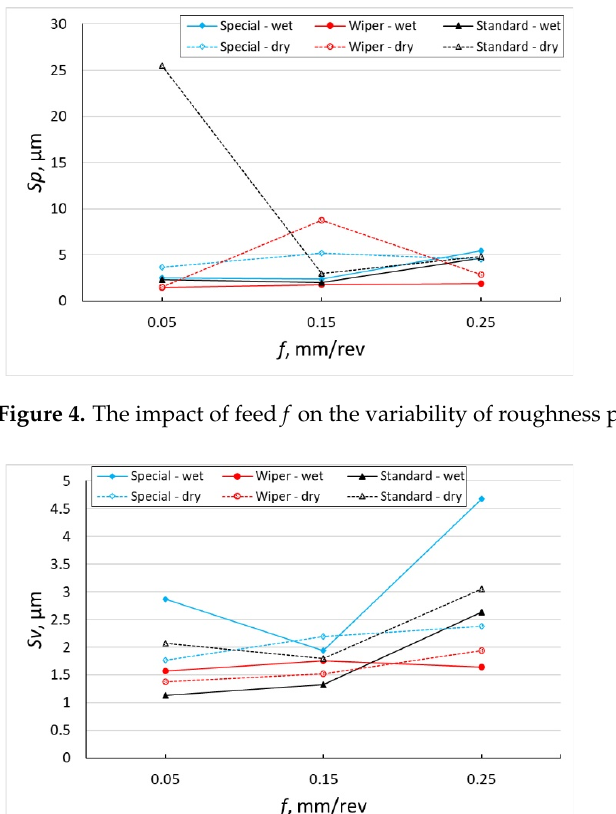
Figure 6. The impact of feed f on the variability of roughness parameter Sz . The roughness parameter, Sa (Figure 7) and the Sq parameter (Figure 8) are not so much dependent on peaks and pits as the Sp , Sv and Sz parameters. However, for the surfaces on which sticking occurs frequently and, consequently, large numbers of peaks are recorded and thus higher values of the Sp parameter, larger differences between the Sa and Sq parameters have been observed. In most examined surfaces, the Sq parameter is about 0.15 µm larger than the parameter Sa . In the case of a surface machined with a conventional insert without cooling, the average value of the Sq parameter is 1.830 µm,